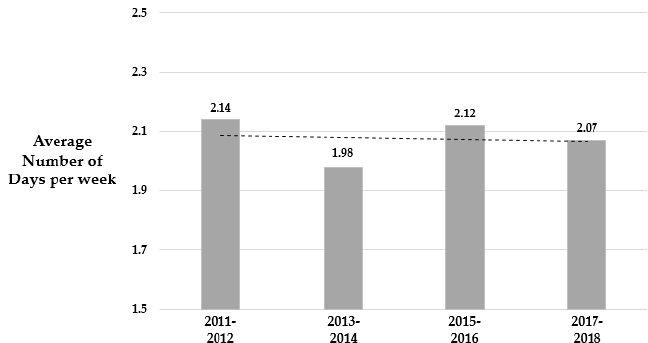
Figure 1. Weighted mean number of participation in physical education for the overall sample from 2011 to 2017 ( N =